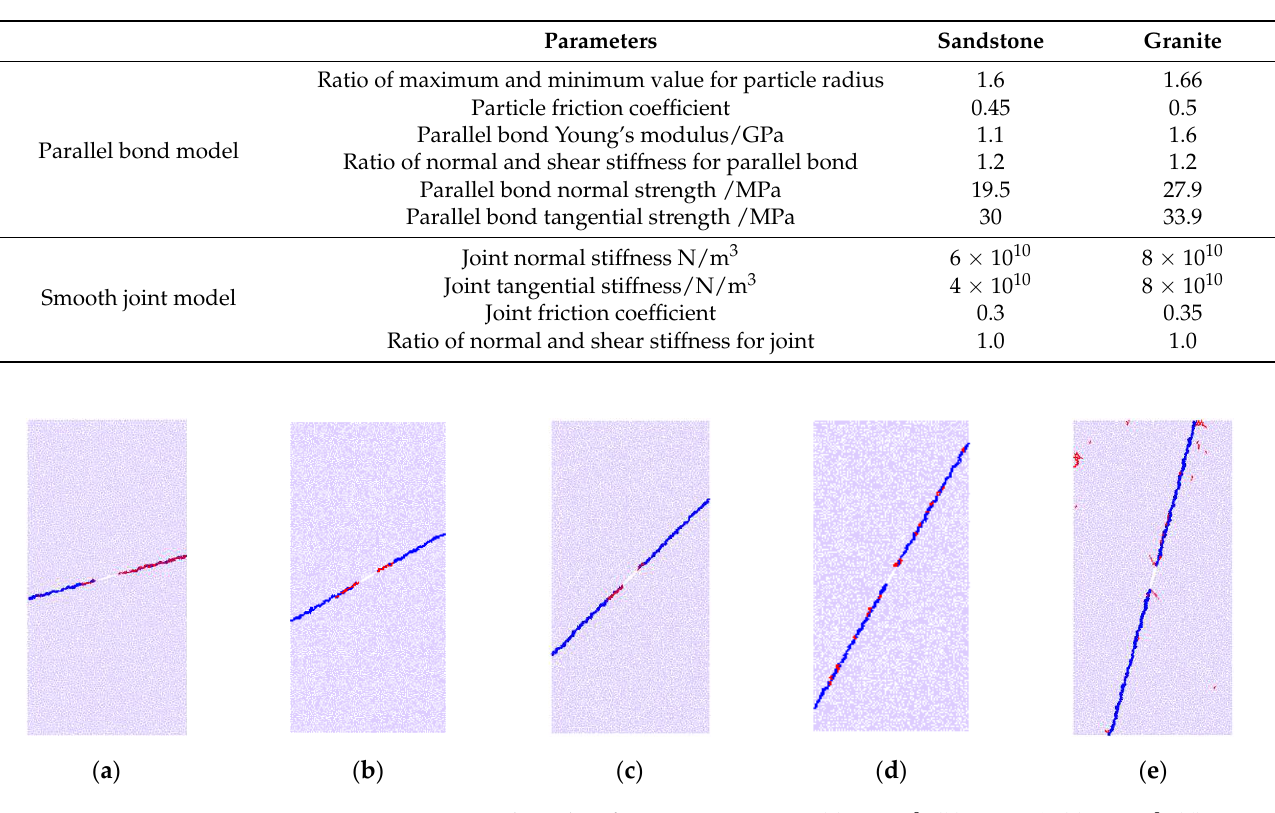
Figure 10. Numerical results of granite specimens: ( a ) β = 15 ◦ ; ( b ) β = 30 ◦ ; ( c ) β = 45 ◦ ; ( d ) β = 60 ◦ ; ( e ) β = 75 ◦